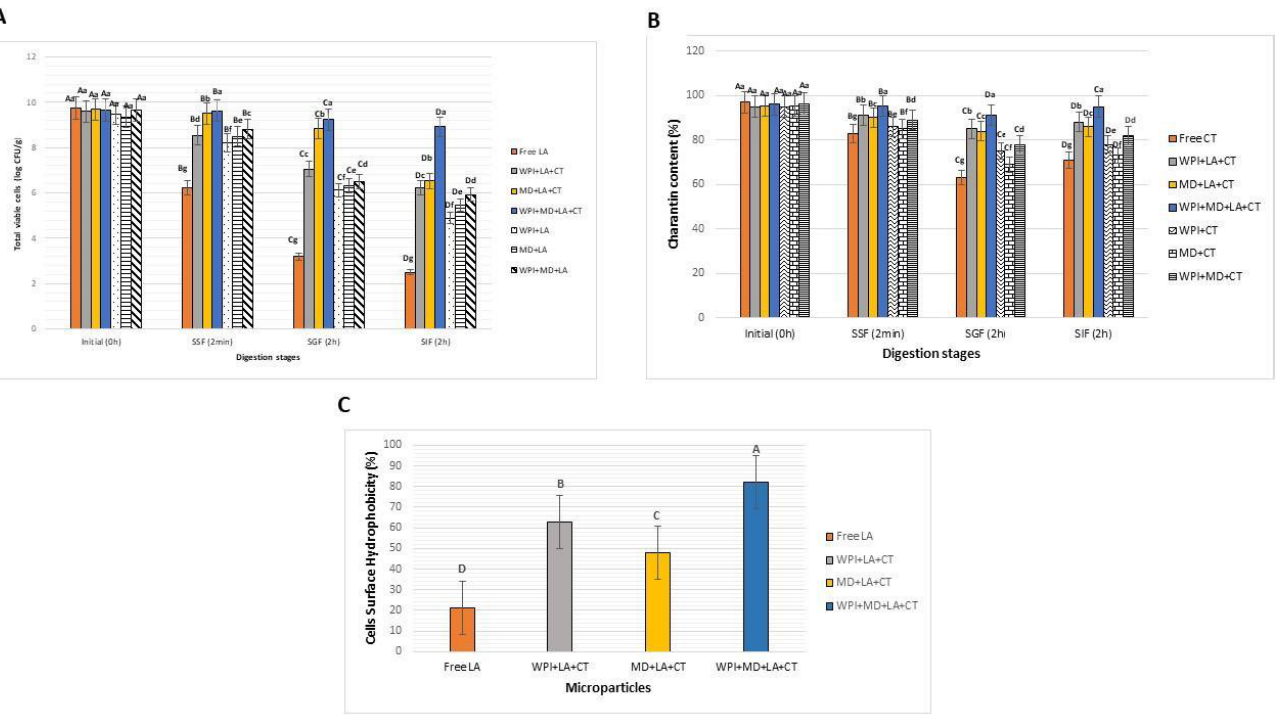
Figure 6. In vitro stability of LA ( A ), CT ( B ) content, and cells surface hydrophobicity of LA ( C ). WPI + LA + CT: Whey protein isolate + L. acidophilus + Charantin ; MD + LA + CT: Maltodextrin + L. acidophilus + Charantin; WPI + MD + LA + CT: Whey protein isolate + L. acidophilus + Maltodextrin + L. acidophilus + Charantin. Different uppercase letters above each column represent significant differences of samples between stages ( p < 0.5), and lowercase letters above each column indicate significant differences between samples within a stage ( p < 0.5).